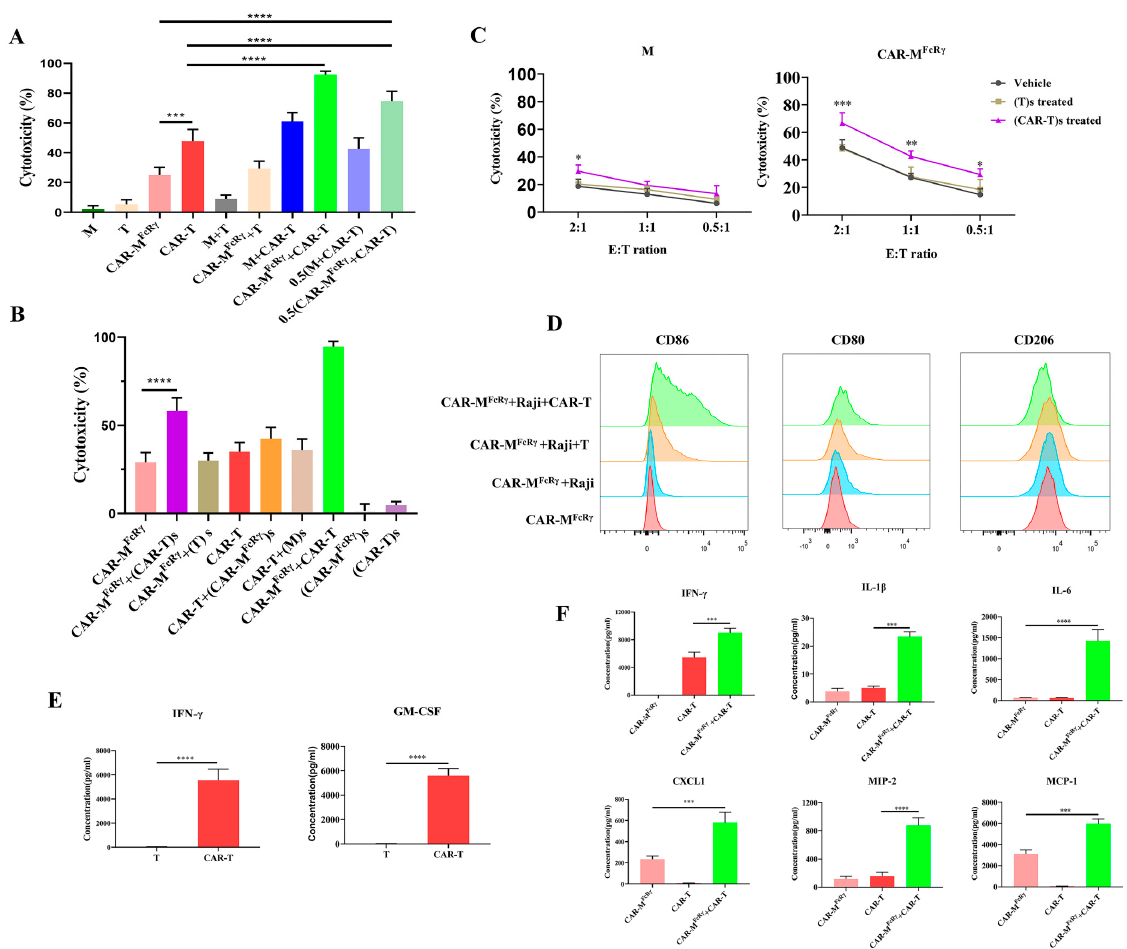
Figure 4. CAR ‐ T and CAR ‐ M demonstrated synergistic cytotoxicity against target cells. ( A ) Cytotoxicity assay against Raji by differ ‐ ent immune effector cells alone or different combination regimens after 48 h coculture at an E:T ratio of 1 (M, T, CAR ‐ M FcR γ , CAR ‐ T, 0.5(CAR ‐ M FcR γ +CAR ‐ T), 0.5(CAR ‐ M FcR γ +CAR ‐ T)) or 2 (M+T, CAR ‐ M FcR γ +T, M+CAR ‐ T, CAR ‐ M FcR γ +CAR ‐ T). M, GFP ‐ M; T, untrans ‐ duced T cells. ( B ) Cytotoxicity assay against Raji by different immune effector cells with normal media or media supplemented with 50% supernatant of immune effector cells and Raji coculture system. The supernatants of T, CAR ‐ T, M or CAR ‐ M FcR γ with Raji cocul ‐ ture system after 48 h at an E:T ratio of 2 were referred to as (T)s, (CAR ‐ T)s, (M)s and (CAR ‐ M FcR γ )s, respectively. ( C ) M or CAR ‐ M FcR γ was treated by (T)s or (CAR ‐ T)s for 24 h prior to cytotoxicity assay against Raji. Assays were performed after 48 h coculture at different E:T ratios (2, 1 or 0.5). ( D ) Flow cytometric analysis of macrophage polarization M1 and M2 surface markers (CD86, CD80, CD206) of CAR ‐ M FcR γ alone or cocultured with Raji, Raji+T, Raji+CAR ‐ T for 48 h at an E:T (T or M effector cell: Raji) ratio of 2. ( E ) IFN ‐γ and GM ‐ CSF released by T or CAR ‐ T cells after coculture with Raji for 48 h at an E:T ratio of 2. ( F ) Cytokine/chemokine released by CAR ‐ T, CAR ‐ M FcR γ , or the combination of CAR ‐ T and CAR ‐ M FcR γ (CAR ‐ M FcR γ + CAR ‐ T) after coculture with Raji for 48 h at an E:T ratio (T or M effector cell: Raji) of 2. Data are represented as the mean ± SD of n =3 biological replicates. Statistical significance was calculated using two ‐ tailed Student t ‐ test or one ‐ way ANOVA analysis (* p ≤ 0.05, ** p ≤ 0.01, *** p ≤ 0.001, **** p ≤